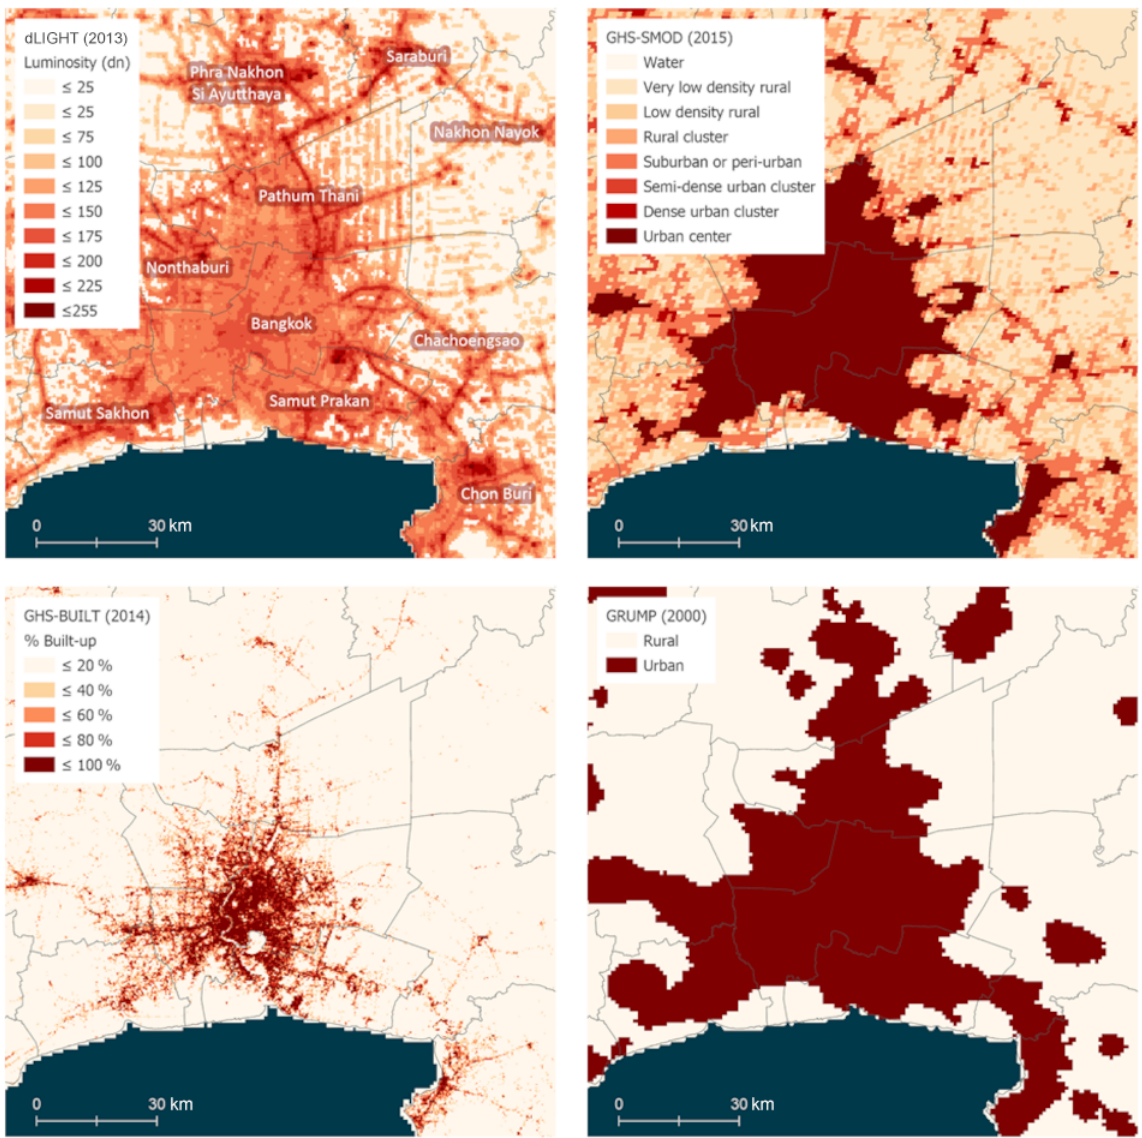
Figure 3. Urban-proxy source data, Bangkok and surrounding areas, Thailand. Note that the dark blue indicates ocean and gray boundaries indicate first-order administrative